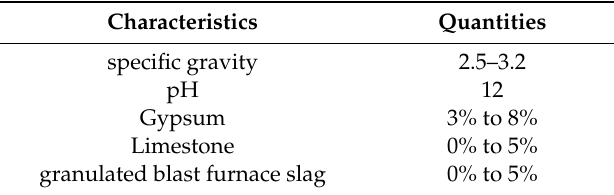
Table 1. Characteristics of the used Type II PC [21].